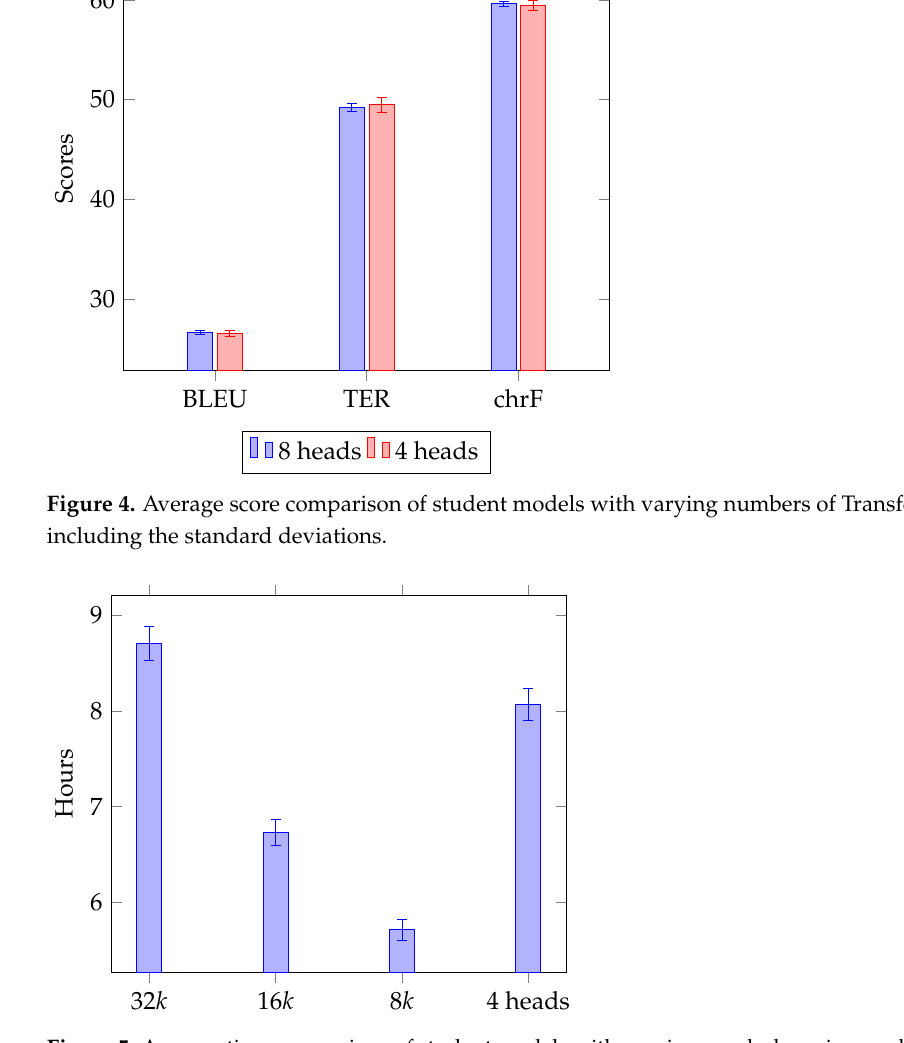
Figure 5. Average time comparison of student models with varying vocabulary sizes and Transformer heads. Where the vocabularies are specified, the number of Transformer heads is equal to 8, while for 4 Transformer heads the vocabulary size is set to 32 k